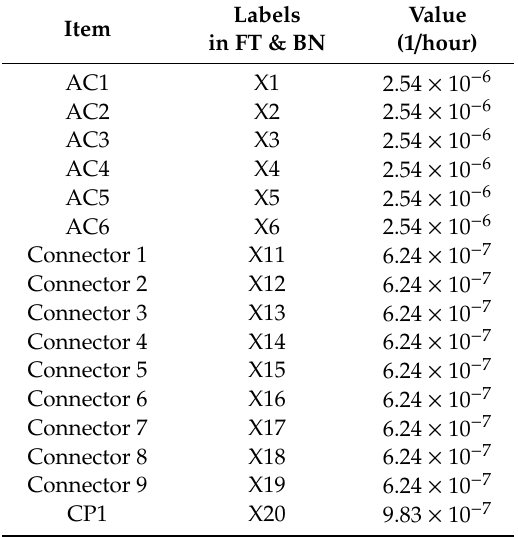
Table 4. Interpretations of nodes in fault tree (FT) and BN